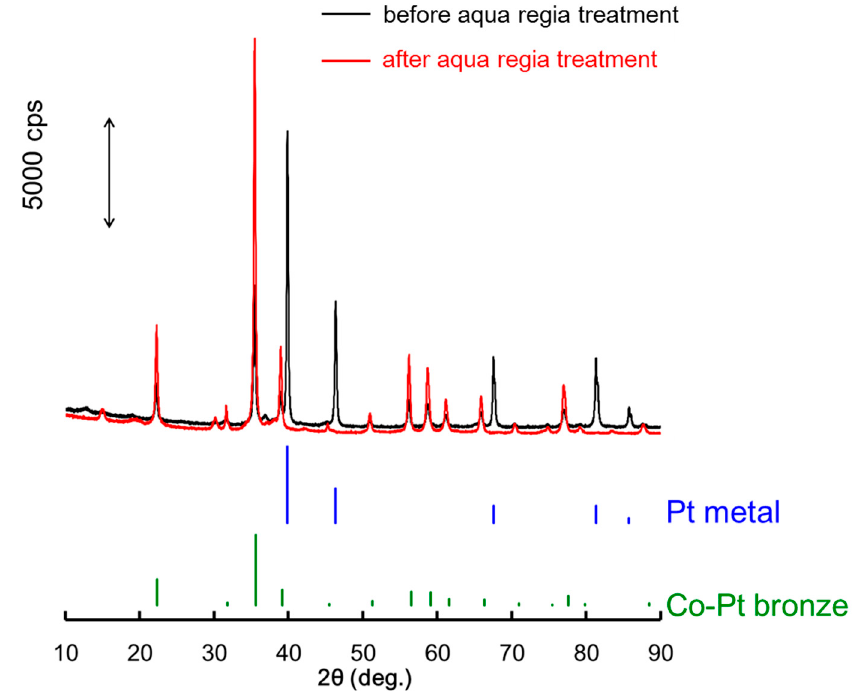
Figure 2. XRD Patterns for Co-Pt bronze before and after aqua regia treatment. Co-Pt bronze peaks were assigned using Rietveld refinement with structural data for CaPt 3 O 4 : PDF#04-002-4036 and CdPt 3 O 4 : PDF#04-002-4050.